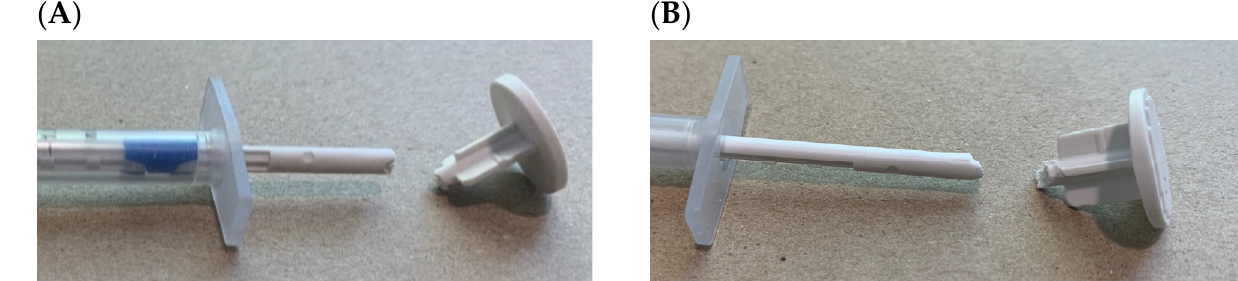
Figure 4. Picture of a broken plunger tops. ( A ) Participant used excessive force while pressing the plunger rod. ( B ) Broken when the participant exerted a lateral force of the plunger rod, snapping off the top of it.